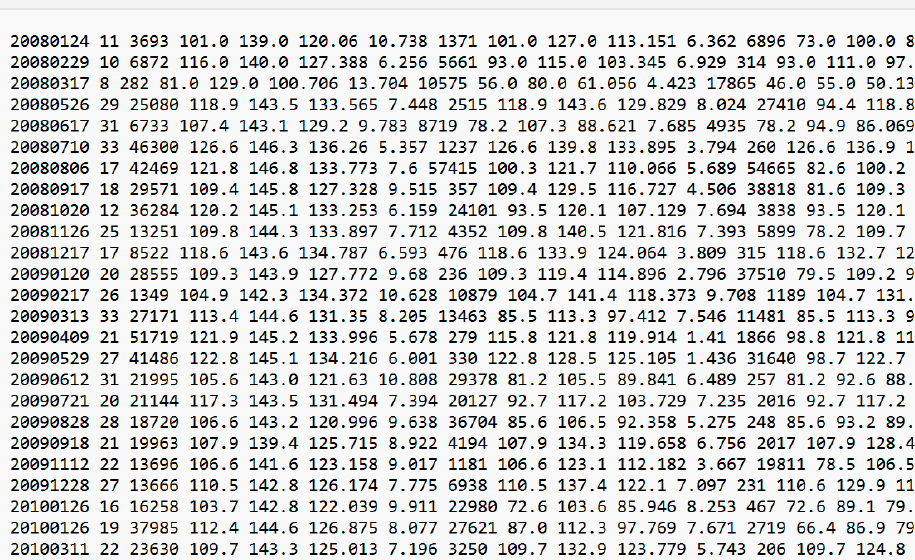
Figure 8. Example of program output: cluster information of an analyzed area. Each row shows the information related to all the hot clusters of an image as described in the text.